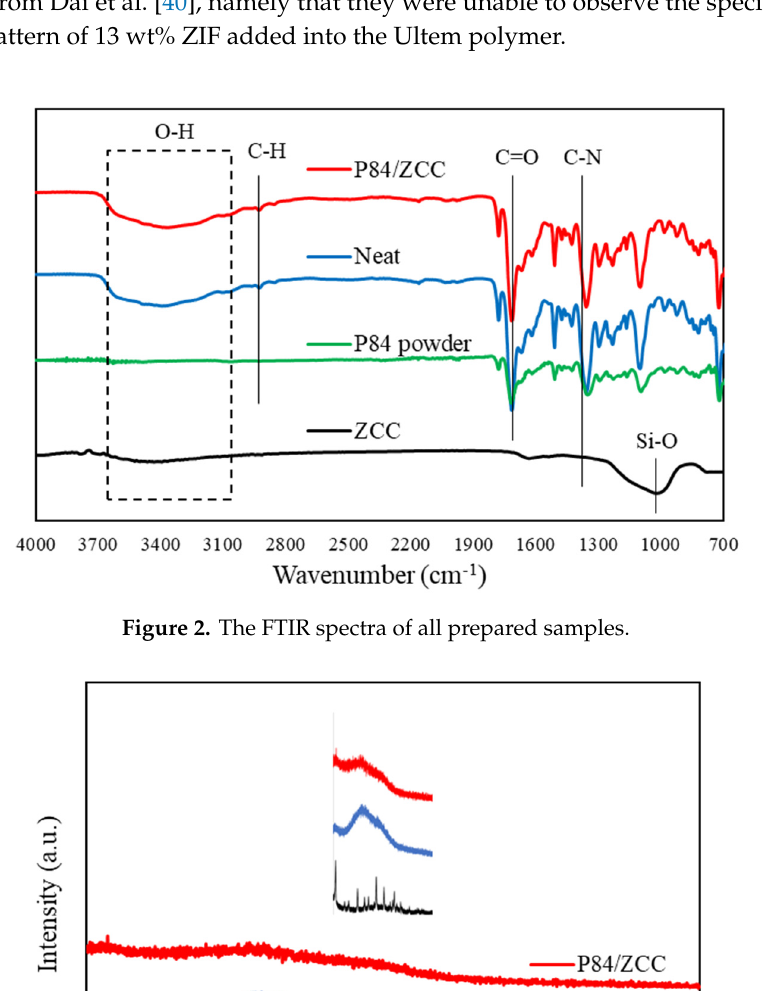
Figure 2. The FTIR spectra of all prepared samples.